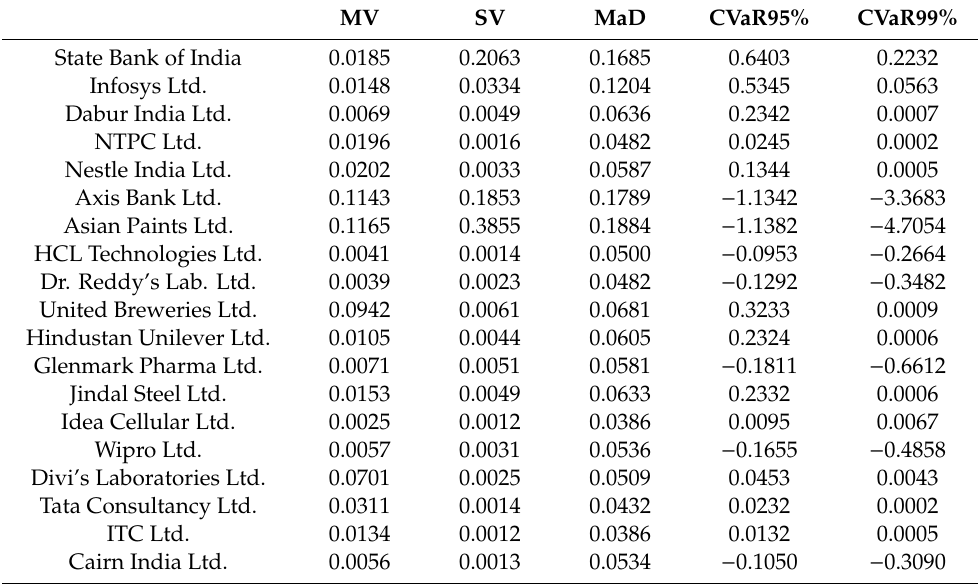
Table 9. Optimal portfolio compositions for economic growth period